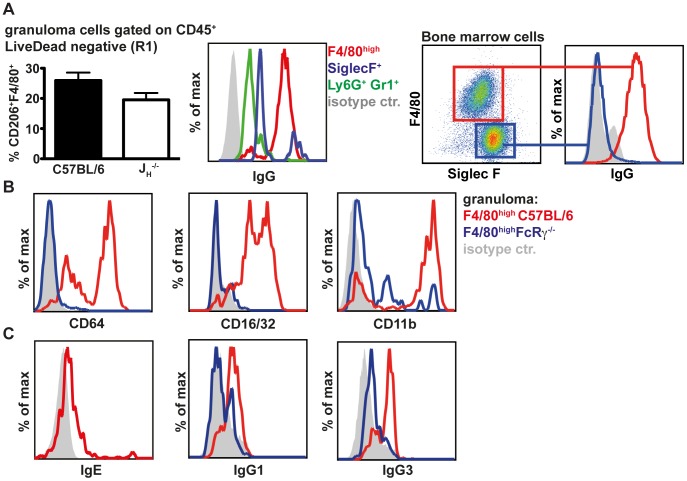
Macrophages are the major IgGhigh population in the granuloma following challenge Hp infection and express high levels of antibody and complement receptors.(A) 25–30 granuloma were excised from the small intestine of challenge Hp infected mice on day 4 p.i. and isolated granuloma cells (left panels) or immune serum activated bone marrow derived cells (right panels) were stained for cell surface markers and IgG. (B) Expression of CD64, CD16/32 and CD11b on granuloma macrophages from C57BL/6 or FcRγ−/− mice; (C) Levels of IgE, IgG1 and IgG3 on granuloma macrophages from C57BL/6 or FcRγ−/− mice; Representative FACS plots from two independent experiments with 4–5 mice per group are shown.